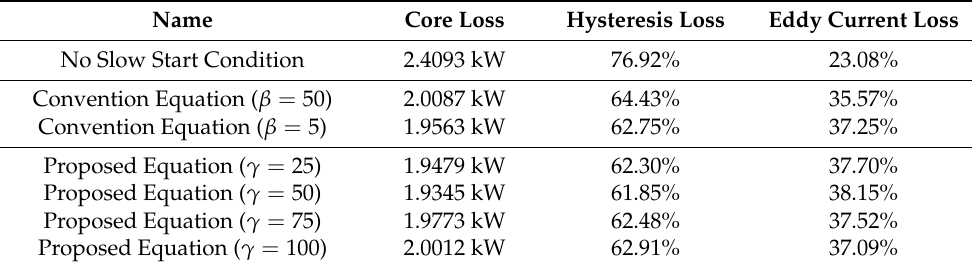
Table 5. Simulation results of the core loss under different slow start functions.